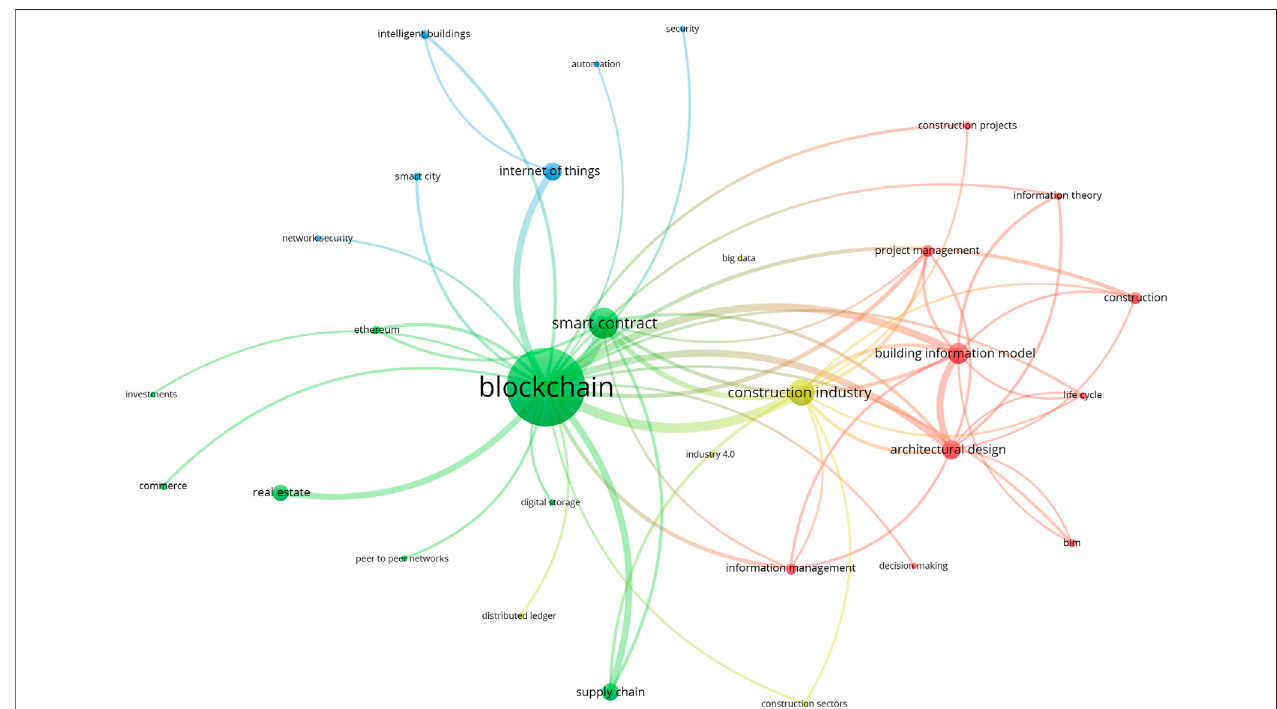
FIGURE3| Bibliometricmapoftheco-occurrenceofthetop-30keywordsofdocumentsincludingblockchaininthecivilengineeringandtheconstructionindustry, in Scopus.